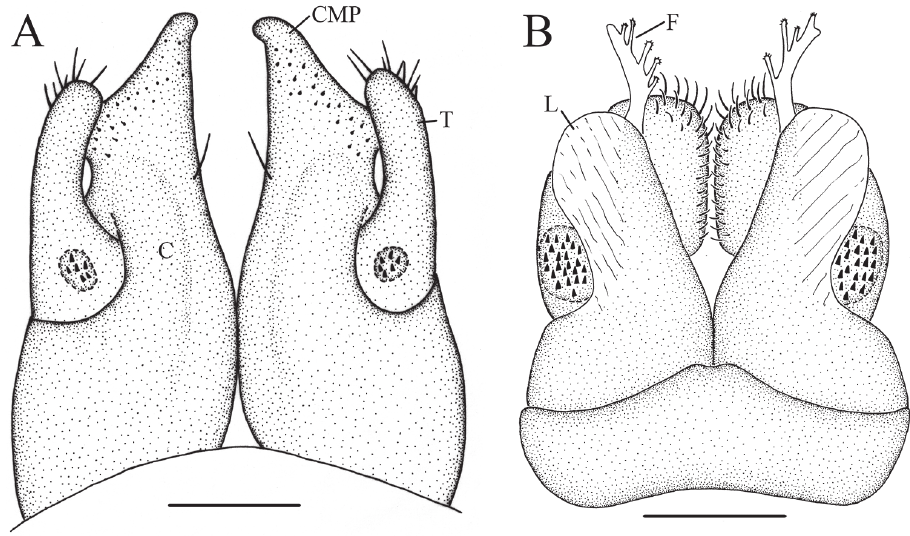
Figure 6. Glyphiulus foetidus sp. n., holotype. A anterior gonopods, caudal view B posterior gonopods, caudal view. Abbreviations: C = coxosternum; CMP = coxosternal mesal process; F = flagellum; L = lamel- liform lobe; T = telopodite. Scale bars: A, B 0.2